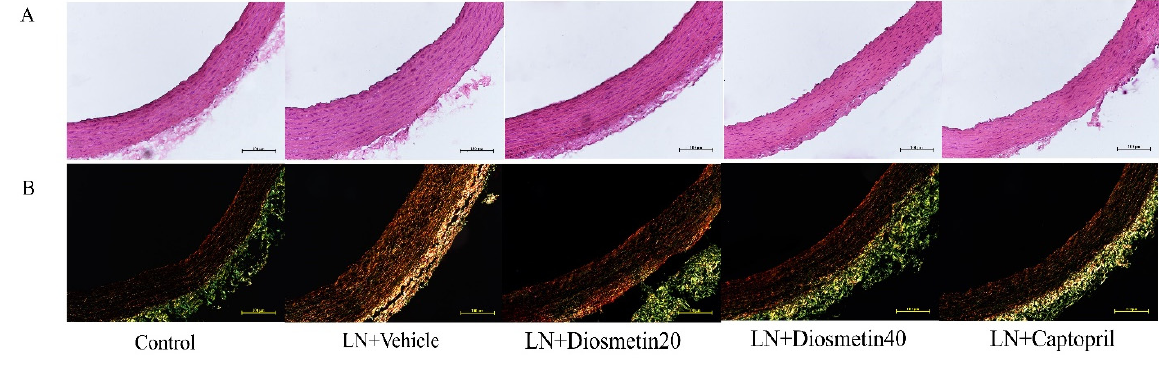
Figure 7. Effect of diosmetin and captopril on the vascular morphology in LN-induced hypertensive rats. Representative figures of a vascular section stained with H&E ( A ) and picrosirius red staining ( B ). Results of the quantitative analyses of vascular remodeling are represented by cross-sectional areas ( C ), thoracic wall thickness ( D ), luminal diameter ( E ), ratios of the wall to lumen ( F ), vascular smooth muscle cell numbers ( G ), and the percentage of collagen deposition ( H ). a p < 0.05 vs. control group, b p < 0.05 vs. LN + vehicle group, c p < 0.05 vs. LN + diosmetin20 group. LN, L-NAME; LN + diosmetin20, L-NAME treated with 20 mg/kg of diosmetin; LN + diosmetin40, L-NAME treated with 40 mg/kg of diosmetin; LN + captopril, L-NAME treated with captopril ( n = 7–8/group). Statistical analysis between the five groups was performed using the one-way ANOVA followed by Turkey’s post hoc test. 3.7. Effect of Diosmetin and Captopril on Vascular IL-6 Expression Immunohistochemical staining showed the enhancement of IL-6 expression in the LN group compared to the control group ( p < 0.05). Treatment with diosmetin and captopril alleviated the expression of IL-6 ( p < 0.05), as shown in Figure 8A,B.